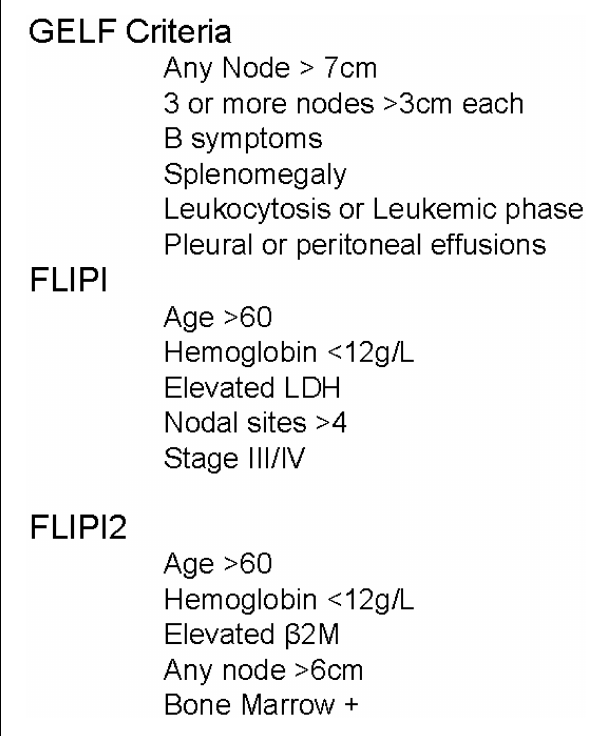
FIGURE 1 | Follicular lymphoma therapy indications and clinical